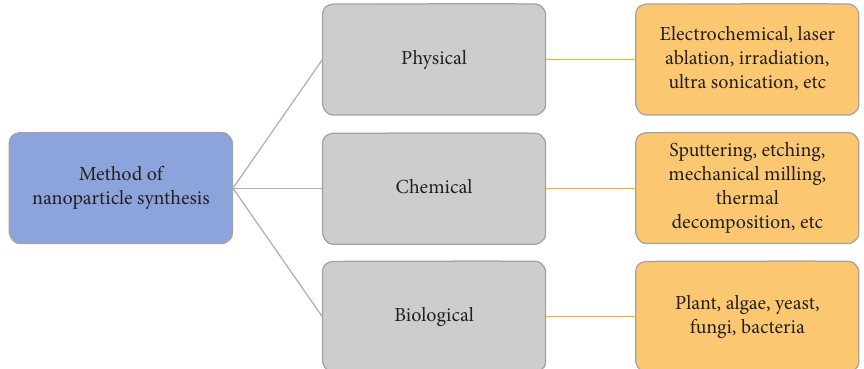
Figure 2: Method of nanoparticle